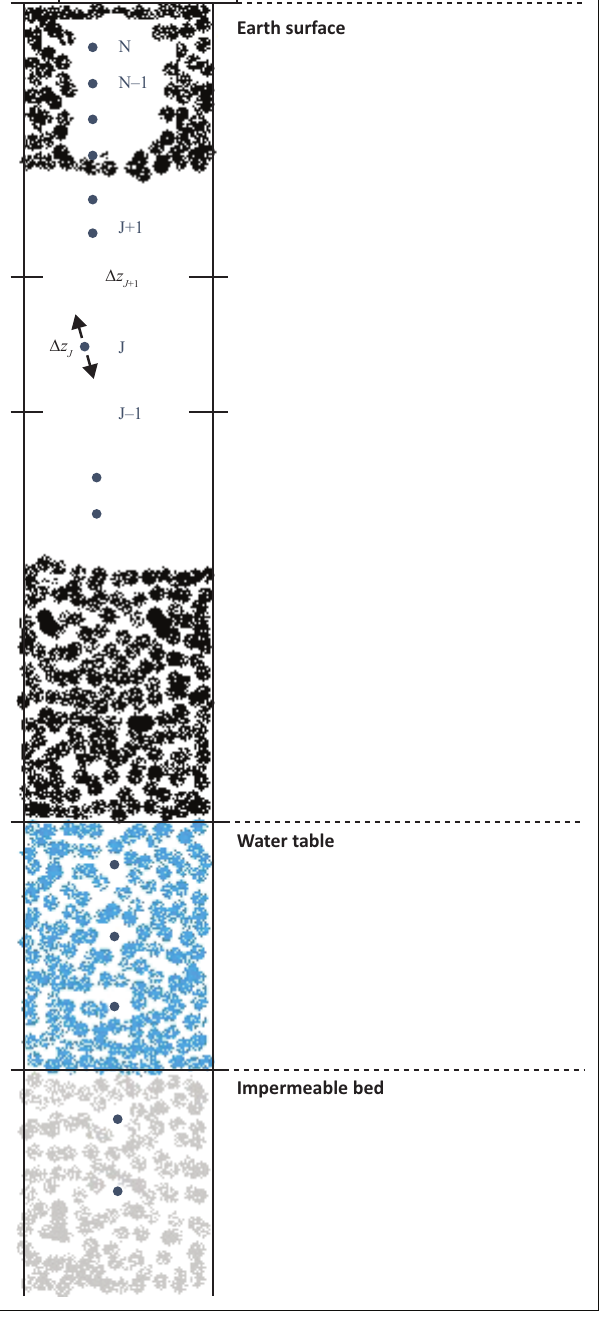
FIGURE 1: Vertical discretisation of a soil